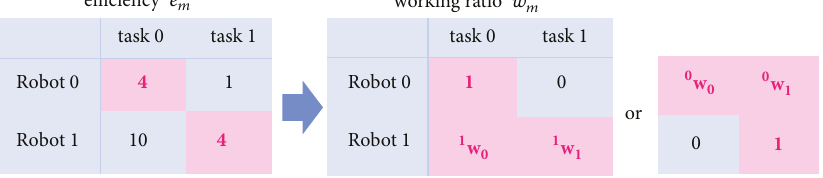
Figure 3: Example of an optimal allocation on the Pareto front.